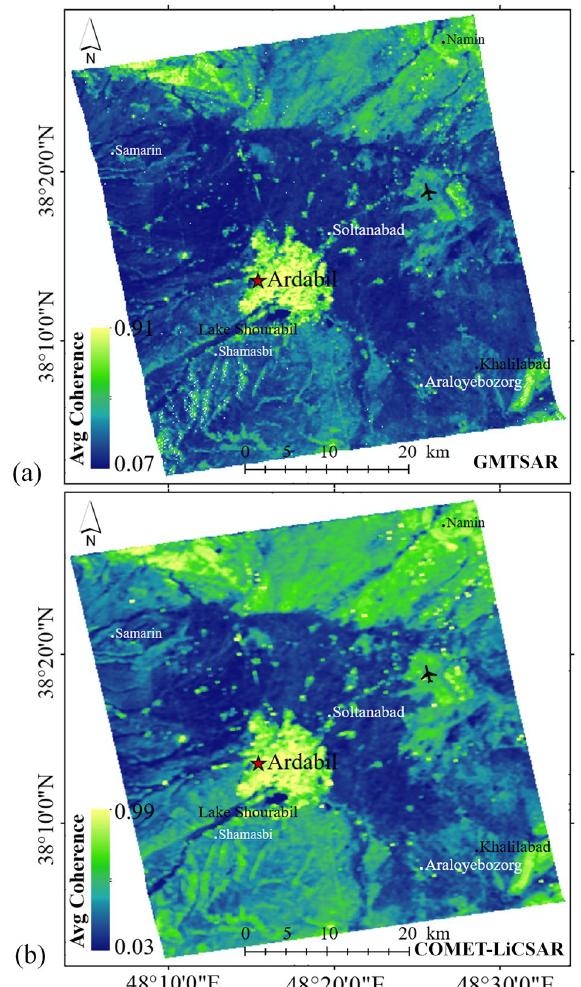
Figure 11. Comparison of the average coherences for the study area: ( a ) GMTSAR and ( b ) COMET-LiCSAR system. This figure was created using the QGIS version 3.14.0-Pi software (https:// qgis. org/ en/